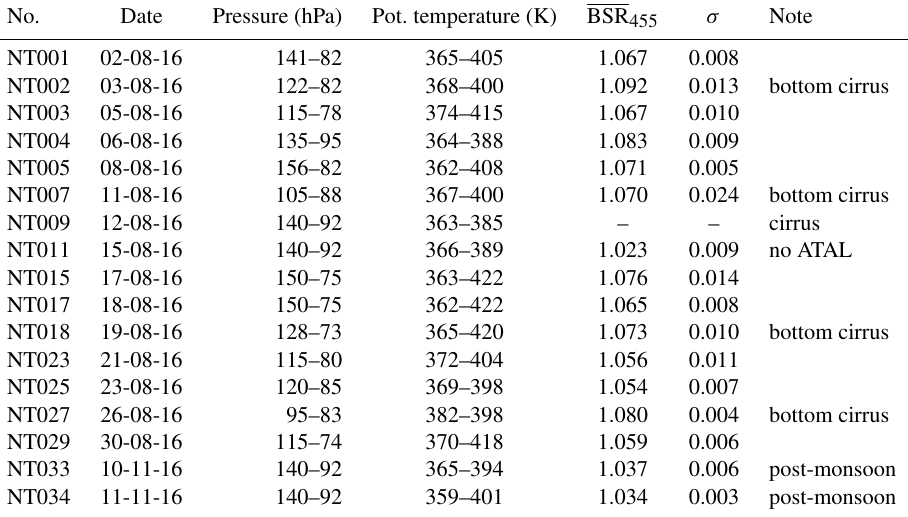
Table 1. Table of all night-time balloon launches analysed here. Listed are number, date, top and bottom of the ATAL noted in both pressure and potential temperature, the mean value of the backscatter ratio (BSR 455 excluding cirrus contributions) and its standard deviation ( σ ) (see Sects. 2.2 and 3.1 for details). Top of the ATAL is defined as the pressure level, where either the BSR 455 profile has the strongest gradient or where BSR 455 merges to the November background. The bottom is defined using the same criteria, except for cases in which the ATAL is limited below by a cirrus cloud (3, 11, 19 and 26 August). On 12 August, the UTLS is filled by a 5km thick cirrus cloud; hence the ATAL cannot be diagnosed. On 15 August 2016, the UTLS was largely cloud-free but without any indication of the ATAL. The November soundings are post-monsoon without the ATAL. For soundings without the ATAL, a reference pressure (140–92hPa) and potential temperature (calculated from the measured temperature and pressure) range is given. This reference range allows comparisons with the ATAL observations to be made (for details, see Sect. 4). Measurements for which the ATAL is limited below by a cirrus cloud and for which a thick cirrus cloud or no ATAL was detected in the UTLS as well as the post-monsoon flights are indicated in the last column of the table (under “Note”) in contrast to the normal ATAL